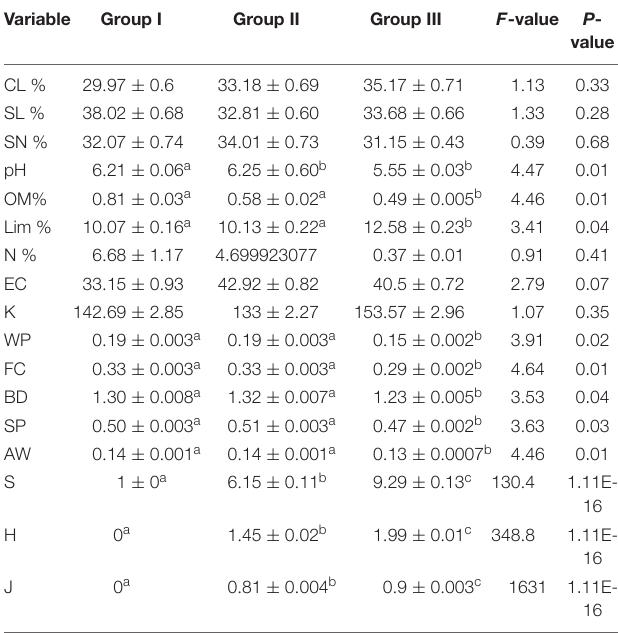
TABLE 2 | Soil and diversity parameters changes with S. marianum invasion along the elevation gradient in Pakistan.